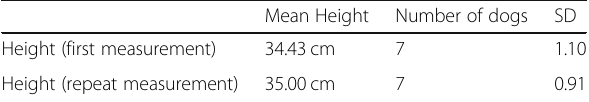
Table 4 Comparison of height measurement results between repeated measurements using the stick measurement technique